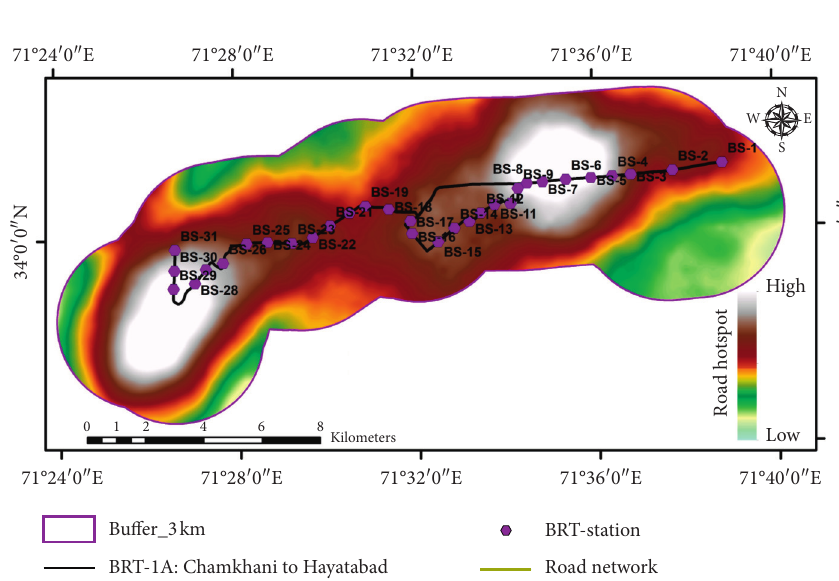
Figure 7: Road hotspot generated using line density function using road line